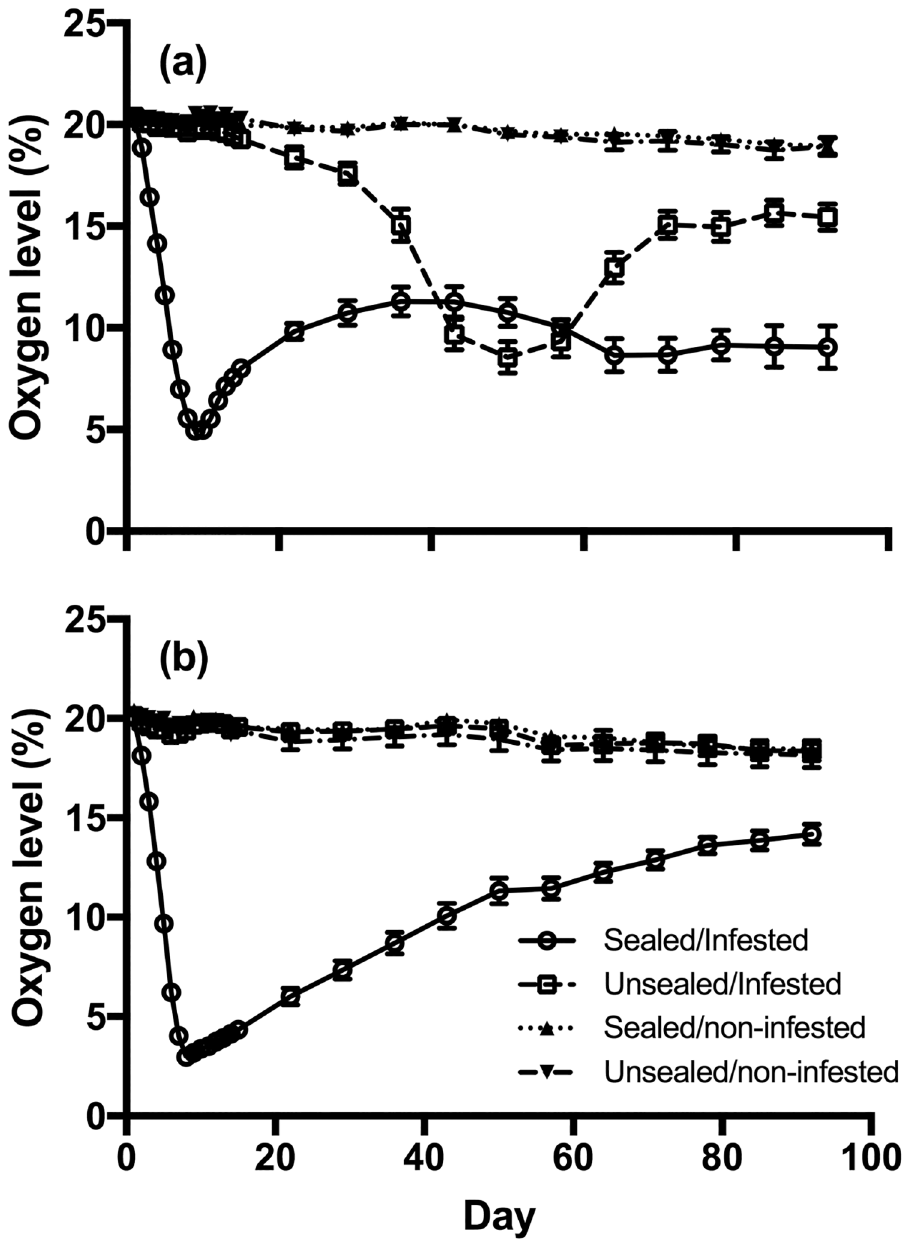
Fig 1. Dynamicsof oxygen levels within PET-bottles containing wheat flour (a) and maize-flour (b) over time. Oxygen readingsfrom sealed infested bottles showeddifferent trends than those observedin unsealed bottles (wheat flour: F (3, 32) = 454.5, P < 0.0001; maize flour: F (3, 32) = 374.3, P < 0.0001). Each data point is the averageof the oxygen levels recordedfrom three Oxydots (upper, middle and bottom) in all three replicates for that treatment. Error bars represent the standarderror of the